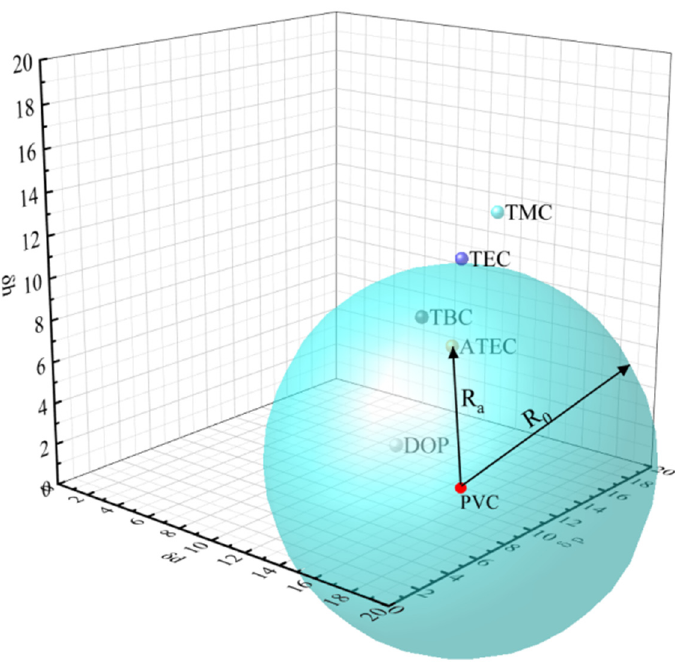
Figure 9. 3D model of Hansen sphere of PVC and the points of citric acid esters and DOP.